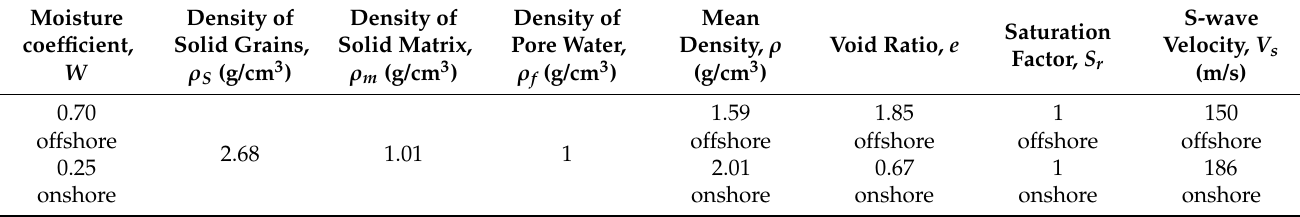
Table 3. Input parameters for the case of clayey silt layer underlain by the flysch